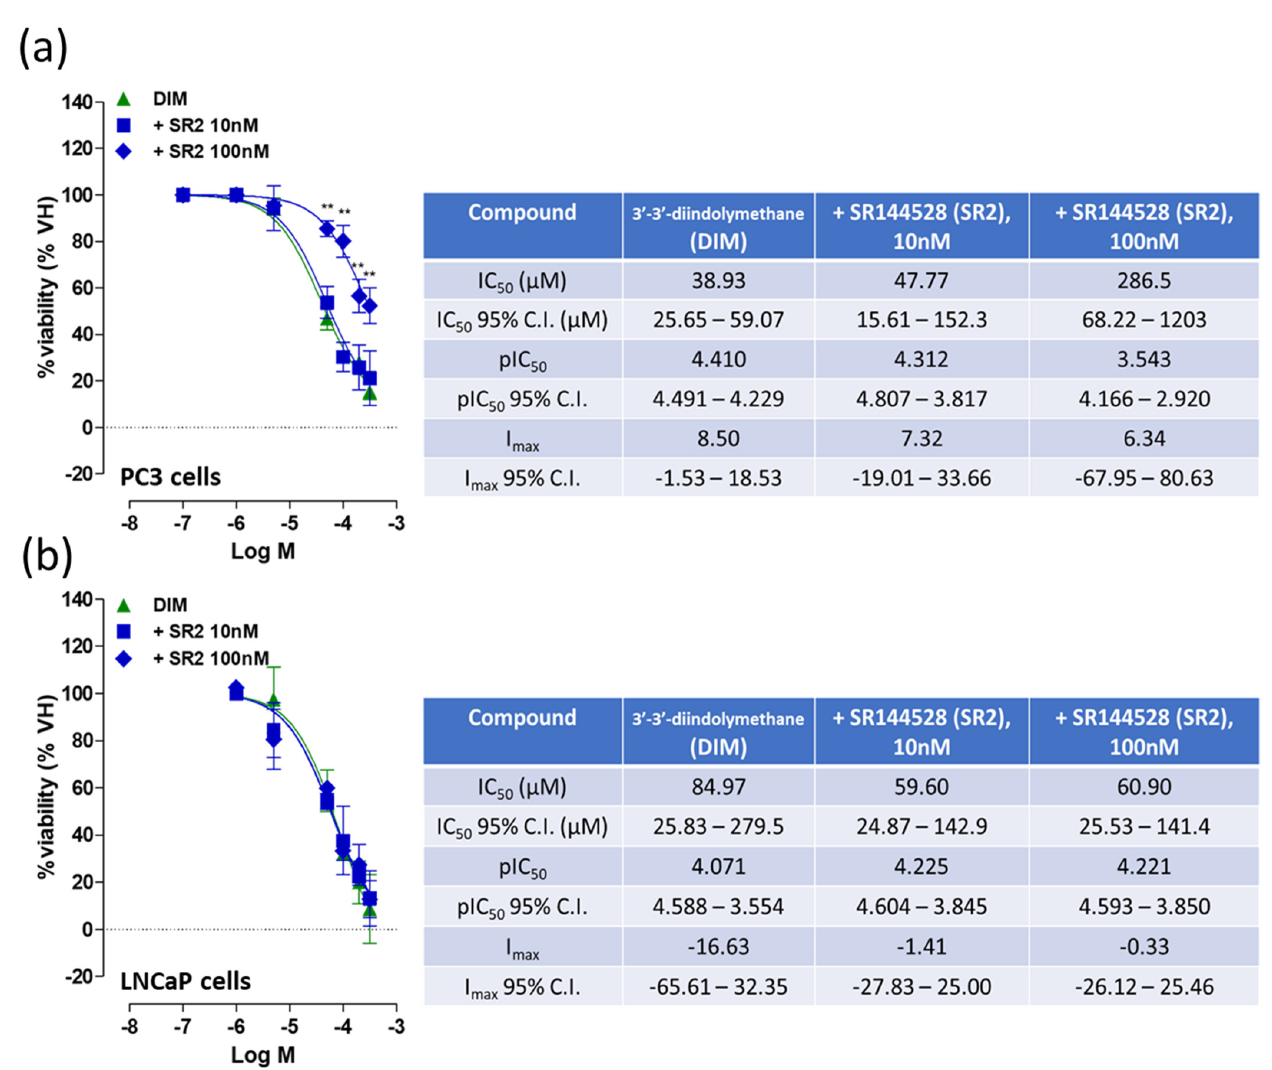
Figure 3. Effects of DIM and different concentrations of the CB 2 receptor antagonist SR2 on cell viability in PC3 cells ( a ) and LNCaP cells ( b ). Each data point is the mean percentage value ± S.E.M ( n = 7). IC 50 , pIC 50 and I max values and 95% confidence intervals are shown in the table. ** p < 0.01 (paired Student’s t -test).